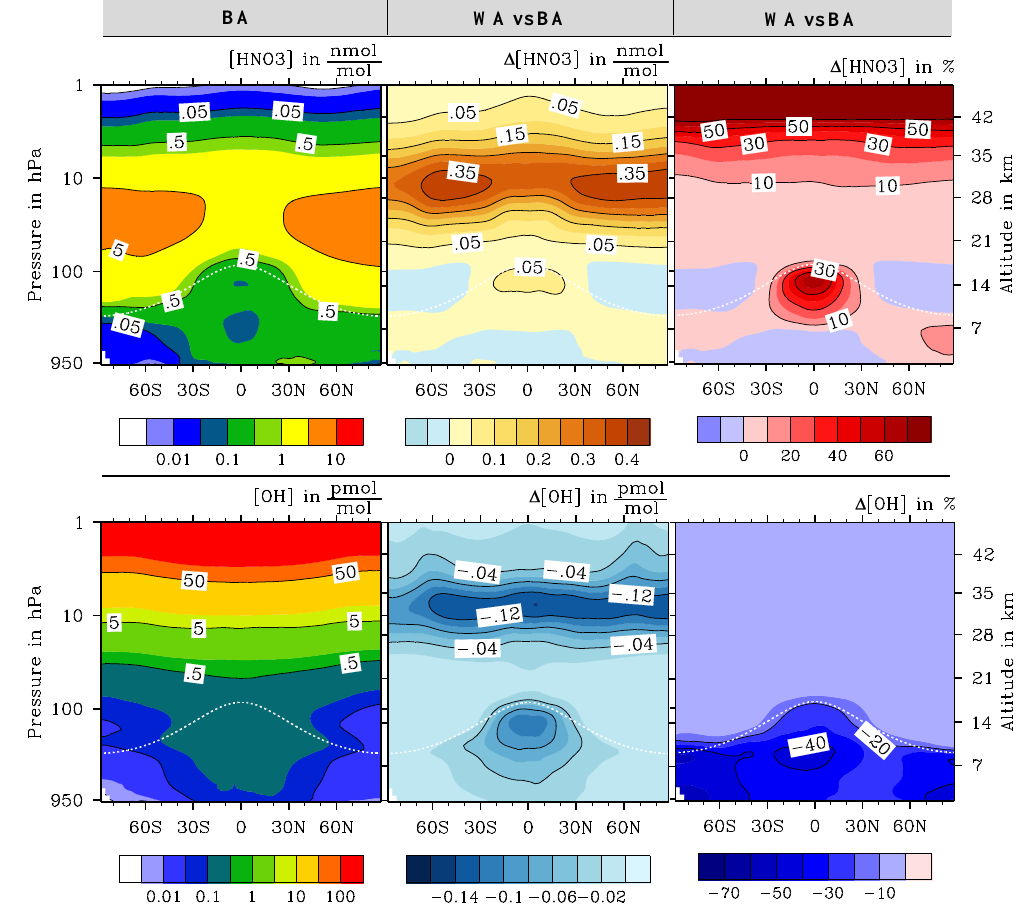
Fig. 1a. Comparison of [HNO 3 ] and [OH] in a simulation with the HNO 3 -forming channel to a reference simulation without HO 2 + NO → HNO 3 . Both simulations have identical aviation NO x emissions. The left column shows annual zonal mean mixing ratios in the reference ) deviations when including the HNO 3 - simulation (BA). The middle and right columns show absolute (WA-BA) and relative (100 · WA − BA BA forming channel with a rate coefficient depending on pressure, temperature and humidity (simulation WA). The plots are cut at 1hPa to zoom into the region of interest, although the uppermost model level is at 0.01hPa. The height values are a logarithmic interpolation from Standard Atmosphere of the pressure array, and the white dotted line shows the climatological tropopause according to Eq.